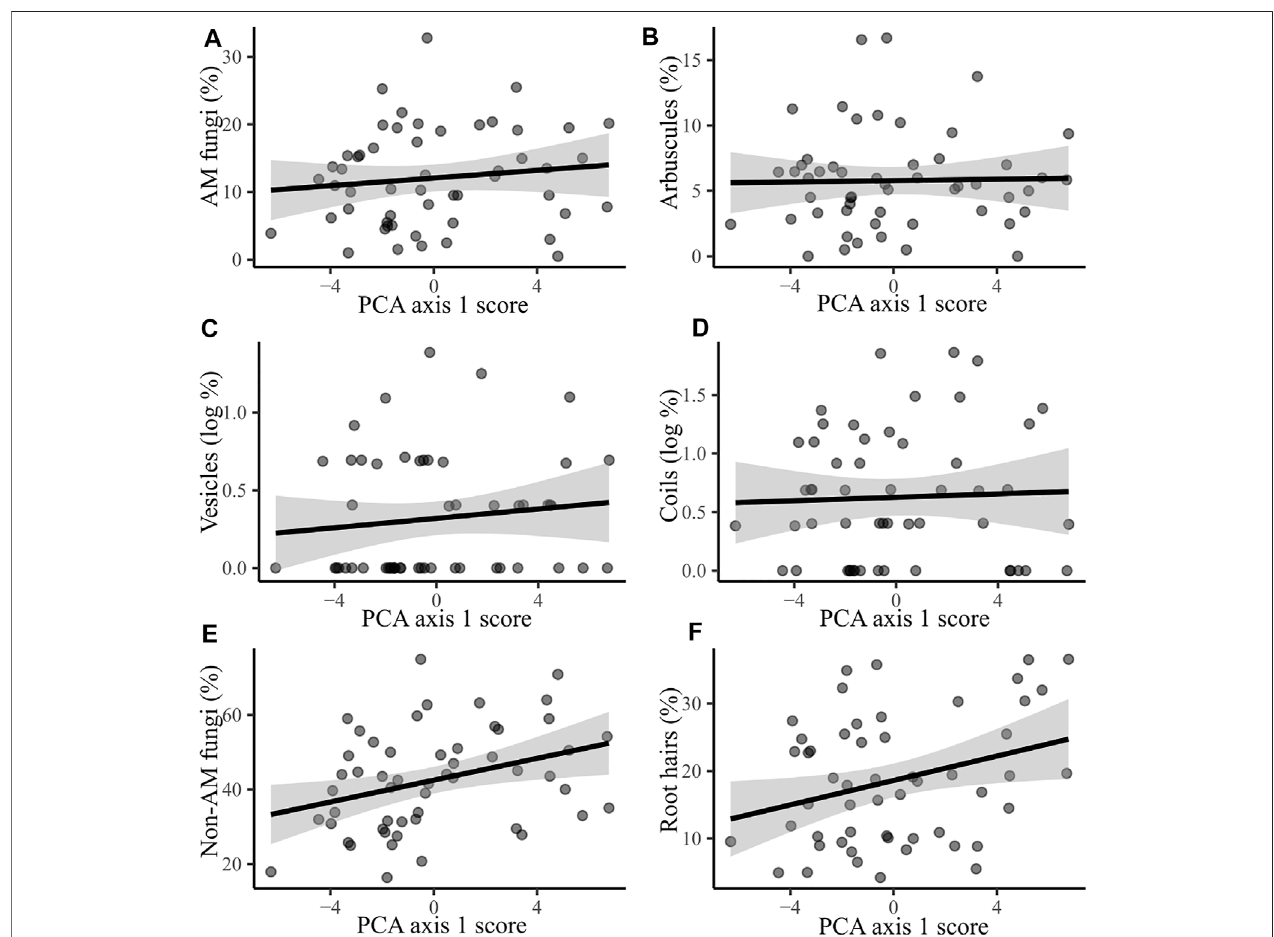
FIGURE 2 | The correlation between PCA axis one score (representing urbanity) and the percentage of root locations containing (A) AM fungi; R 2 = 0.016, F = 0.821, p = 0.369. (B) Arbuscules; R 2 = 0.001, F = 0.026, p = 0.873. (C) Vesicles (log transformed); R 2 = 0.015, F = 0.787, p = 0.379. (D) Coils (log transformed); R 2 = 0.002, F = 0.088, p = 0.768. (E) Non-AM fungi; R 2 = 0.117, F = 6.763, p = 0.012. (F) Root hairs; R 2 = 0.094, F = 5.283, p = 0.026. Shaded areas represent 95% con fi dence intervals. For scatter plots of responses to all three PCA axes, see Supplementary Figure S3